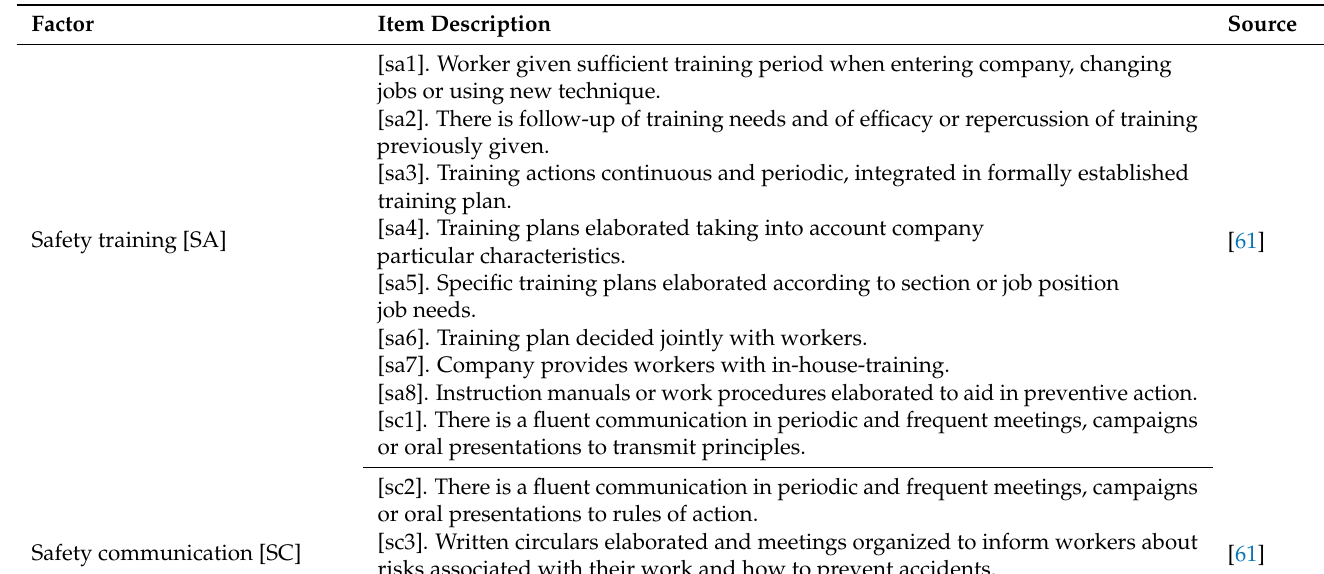
Table A1. Survey’s elements and its